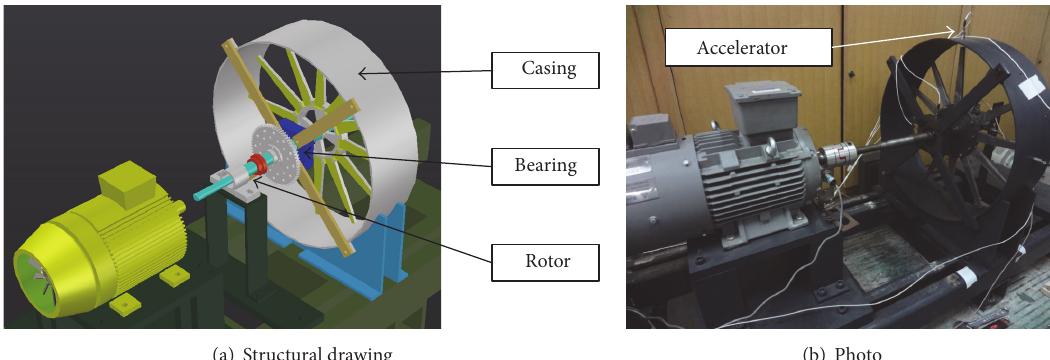
Figure 5: Rotor-bearing-casing test